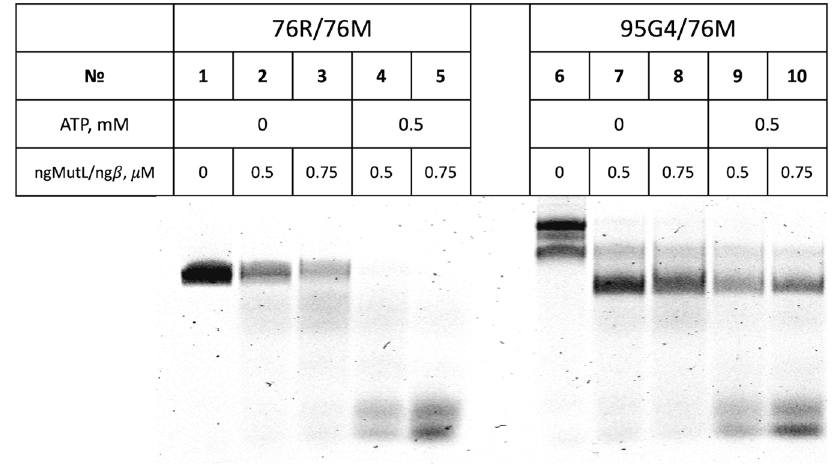
Figure 9. Effect of ATP on ngMutL-induced hydrolysis of the 76R/76M (lanes 1–5) and 95G4/76M (lanes 6–10) (10 nM). The reaction mixtures were incubated in the presence of 0 or 0.5 mM ATP, 5 mM MgCl 2 , and 5 mM MnCl 2 for 90 min at 37 °C and then analyzed in a 12% polyacrylamide gel containing 7 M urea. Additionally, 0.5 µM ngMutL (per dimer) was used in the presence of an equimolar amount of ng β dimer. Electropherogram of 3 ′ -TAMRA-labeled DNA cleavage products is shown.